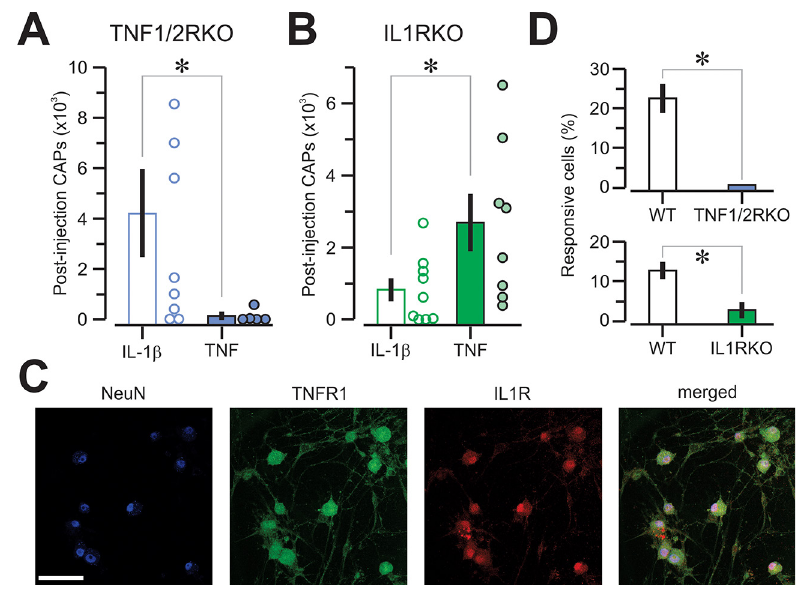
Figure 7. Genetic ablation of cytokine-mediated neurograms. (A, B) Plots showing the total CAP count in the 5-min period immediately after IL-1 β or TNF administration in KO mice. (A) In TNFR1/2KO mice, responses for IL-1 β ( N = 8) and TNF ( N = 5) are significantly different (*, P < .05, MW test). (B) In IL1RKO mice, CAPs for IL-1 β ( N = 8) and TNF ( N = 8) are also statistically significant (*, P < .05, MW test). (C) Cultured nodose ganglia are stained for NeuN (left panel) to identify all cultured neurons, antibody for TNFR1 (green panel) and antibody for IL1R (red panel); merged signals are shown in the right panel. Scale bar, 50 μ m. (D) Responsive neurons display a ≥ two-fold increase in Fluo-4 fluorescence in re- sponse to 100 ng/mL cytokine. (Top) Plot of neurons that respond to TNF in WT ( N = 7) and TNFR1/2KO ( N = 7) mice. (Bottom) Neurons that respond to IL-1 β in WT ( N = 5) and IL1RKO ( N = 4) groups; *, P < .05, MW